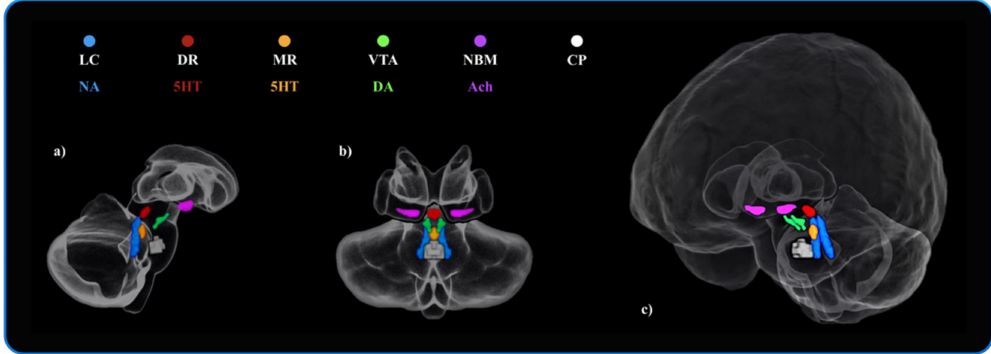
Figure 2. The neuromodulators’ seeds and the neuromodulator-free control region investigated in the VBM analyses. Blue: Locus Coeruleus (LC—“omni-comprehensive”)—Noradrenaline (NA)—(714 voxels). Red: Dorsal Raphe Nuclei (DR)—Serotonin (5HT)—(174 voxels). Orange: Median Raphe Nuclei (MR)—Serotonin (5HT)—(108 voxels). Green: Ventral Tegmental Area (VTA)—Dopamine (DA)—(252 voxels). Purple: Nucleus Basalis of Meynert (NBM)—Acethylcholine (Ach)—(492 voxels). White: Control Pontine ROI (“neuromodulator-free” region)—(906 voxels). All the ROI binary masks were symmetrical with a 1 mm3 isotropic voxel size, and there were no overlapping boundaries between the masks. Image ( a ) displays the anatomical localization of the six ROIs in sagittal view of the Cerebellum, Brainstem and Diencephalon. Image ( b ) displays the coronal view. Image ( c ) shows a fronto-lateral view of the whole brain and the anatomical localization of the six